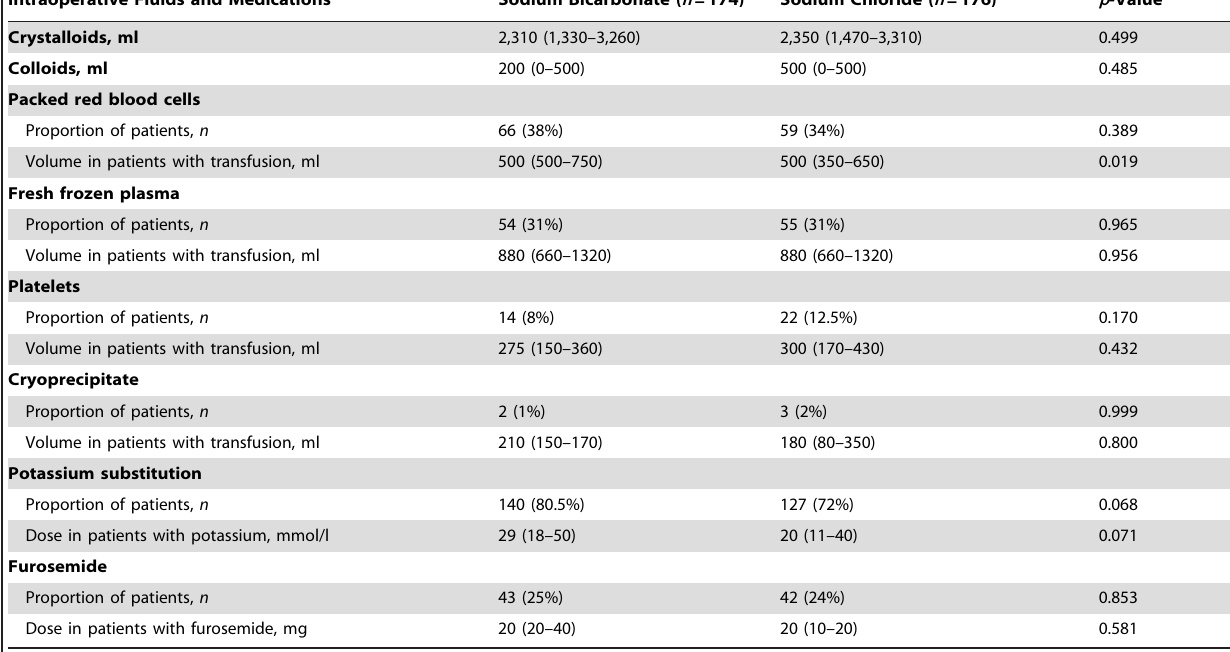
Intraoperative Fluids and Medications Sodium Bicarbonate ( n